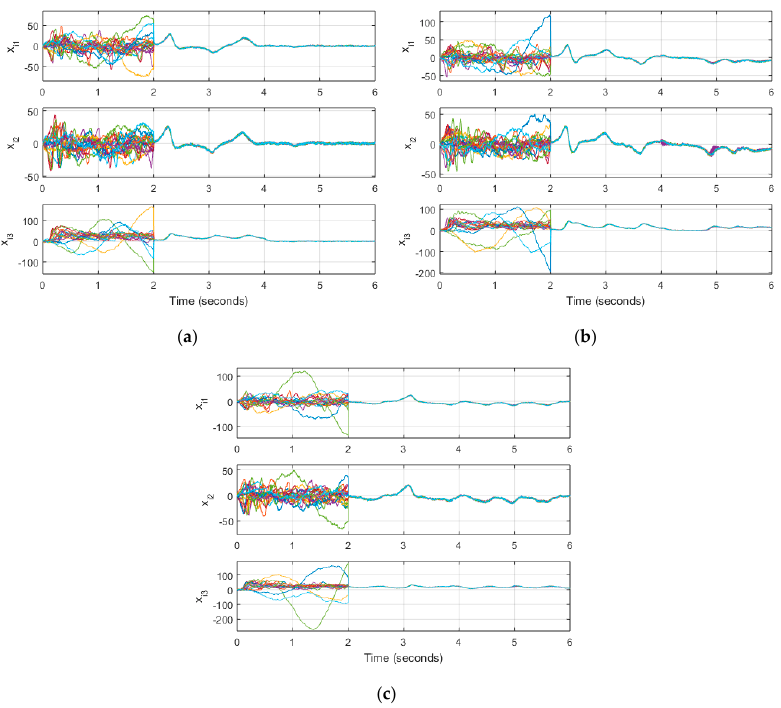
Figure 9. Complex network node dynamics when there are two controlled nodes, there is noise in the system, control gains are d 3 = d 4 = 200, and: ( a ) Control input is applied at every time step; ( b ) Control input is applied every 5T; ( c ) Control input is applied every 10T.